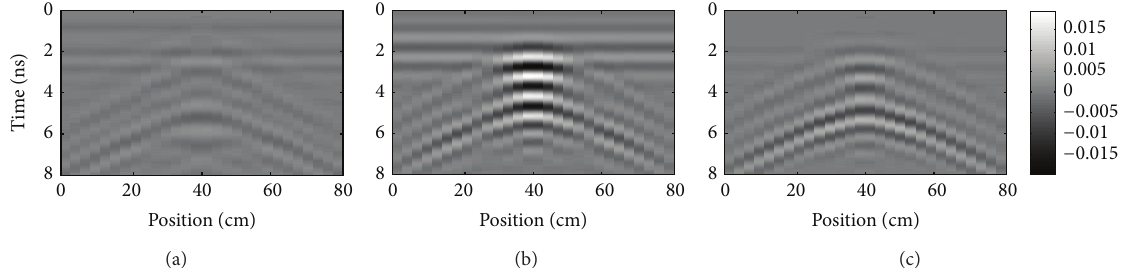
Figure 2: GPR B-scan synthetic radargrams from our numerical setup for a basalt cube of 10cm side, buried 10cm deep from an air/sand interface (details on the other physical parameters are in the main text for this and the subsequent figures). Grey-scale received-signal amplitude in time versus longitudinal scanning position along 𝑥 , for three parallel lines at different 𝑦 : (a) line 1; (b) line 5; (c) line 8. Here and for all the other synthetic radargrams (Figures 3–5), the scatterer is located in a central position along 𝑥 .